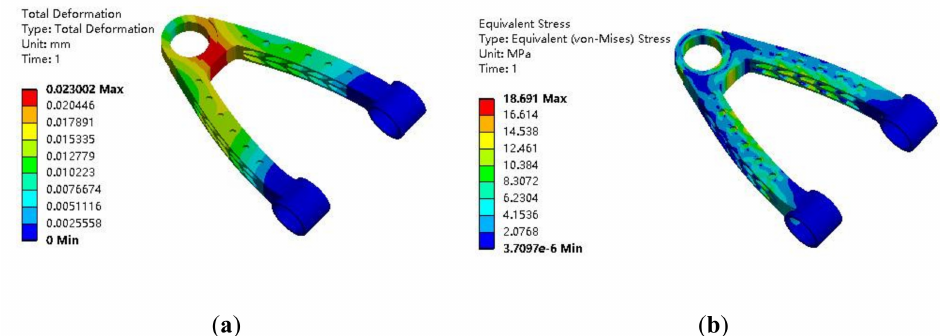
Figure 20. The FEA results of the bionic model: ( a ) displacement distribution; ( b ) stress